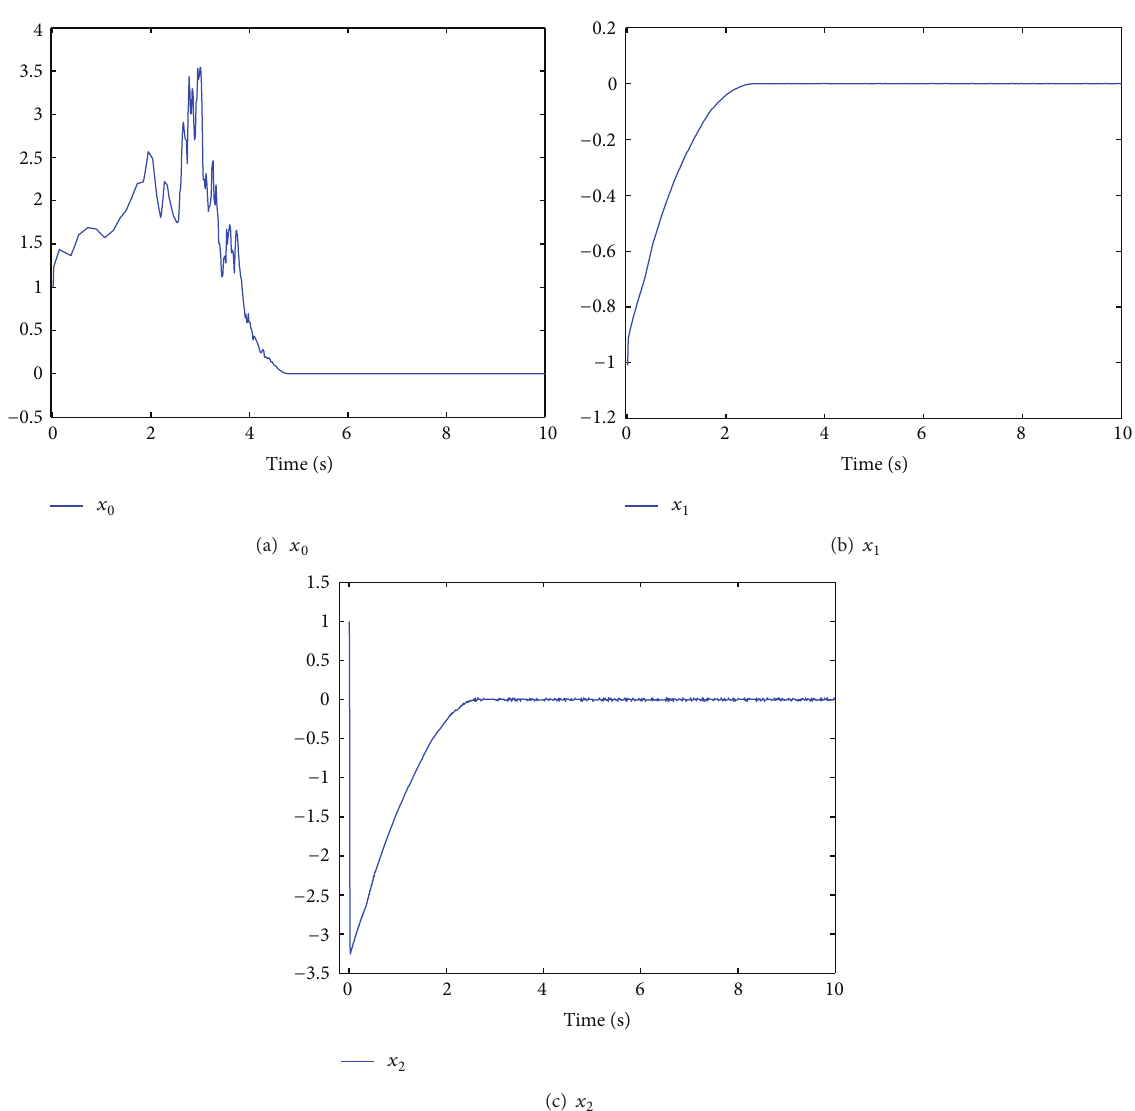
Figure 1: States of the closed-loop